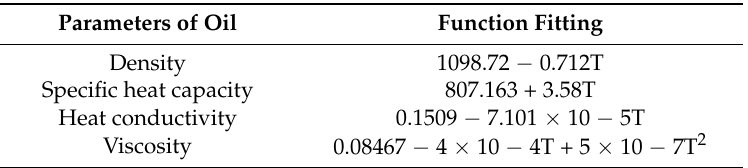
Table 1. Physical parameters of transformer